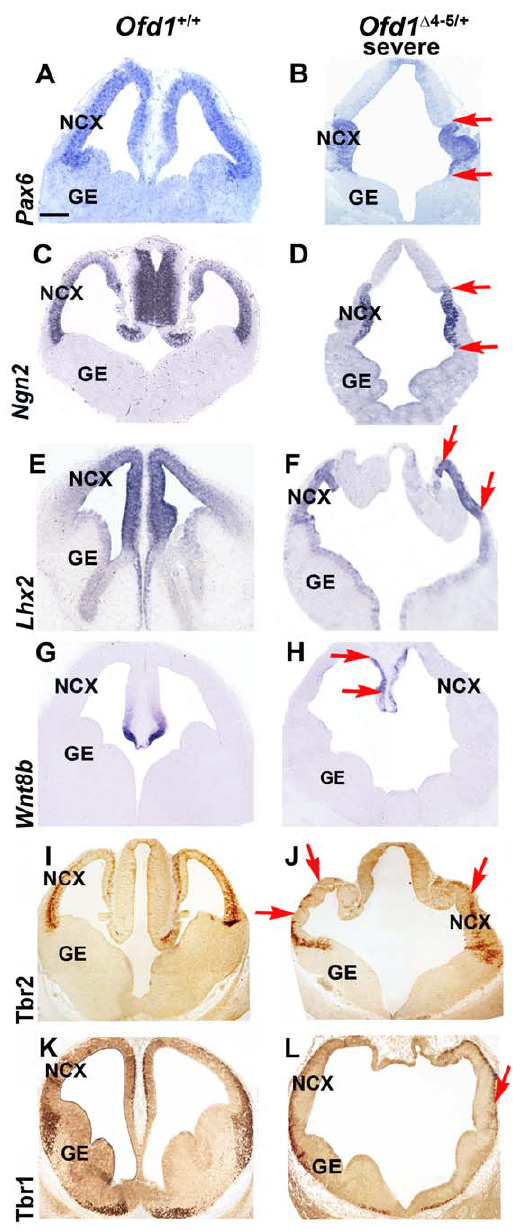
Figure 2. Markers of the dorsal telencephalon are preserved in the absence of Ofd1. Pax6 and Ngn2 expression in the forebrain of wild-type (A, D) and Ofd1 mutants (B, C, E, F) analyzed by ISH on coronal sections at E12.5. These transcripts are normally expressed in Ofd1 + / + wild-type and Ofd1 D 4–5/ + heterozygous females in the dorsal part of telencephalon. In Ofd1 D 4–5/ + heterozygous females displaying a severe phenotype expression was detected exclusively in the presumptive neocortex (red arrows in B, D), but was absent in the dorsomedial regions. mRNA expression of Lhx2 was detected in the dorsal telencephalon in a high dorsomedial to low lateral gradient (Figure 2E) [32]. Similarly to Pax6 and Ngn2 , Lhx2 expression lost its expression gradient, but was still maintained in the malformed cortex (red arrows in Figure 2F), and not ectopically expressed in the protruded dorsomedial structure in severely affected O fd1 D 4–5/ + mutant embryos. mRNA expression of Wnt8b was detected in dorsomedial cortical structures, but not in the cortical primordium (Figure 2G) [33]. Severely affected O fd1 D 4–5/ + mutant embryos showed only a slight expansion of Wnt8b expression dorsomedially (red arrows in Figure 2H), indicating that the abnormally protruded dorsomedial structure